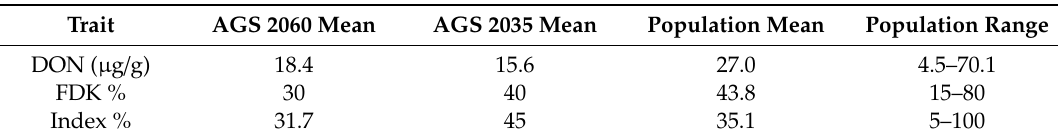
Table 5. Descriptive statistics for FHB resistance ratings of AGS 2060 x AGS 2035 DH population at Newport,